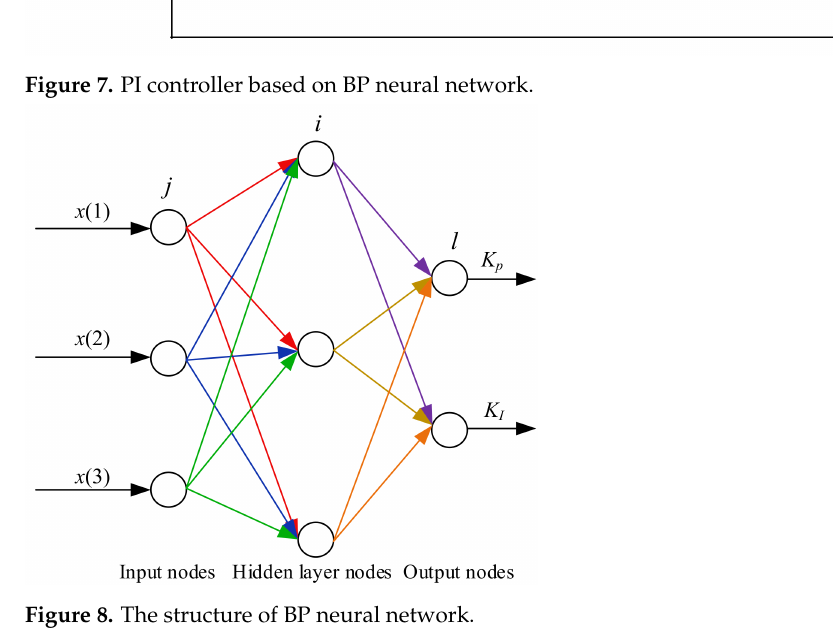
Figure 8. The structure of BP neural